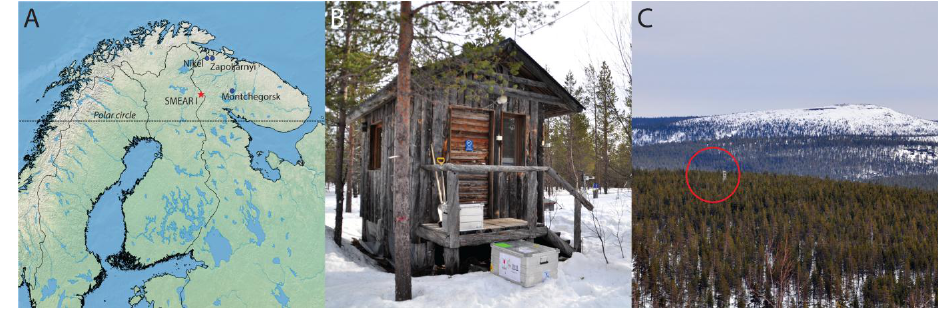
Fig. 1. Location of SMEAR I (Värriö) station and three major mining cities in the Kola Peninsula (A) . The polar circle is also shown on the map. A photo of SMEAR I station (B) and an aerial photo of the surroundings (C) . The location of SMEAR I is circled with red.